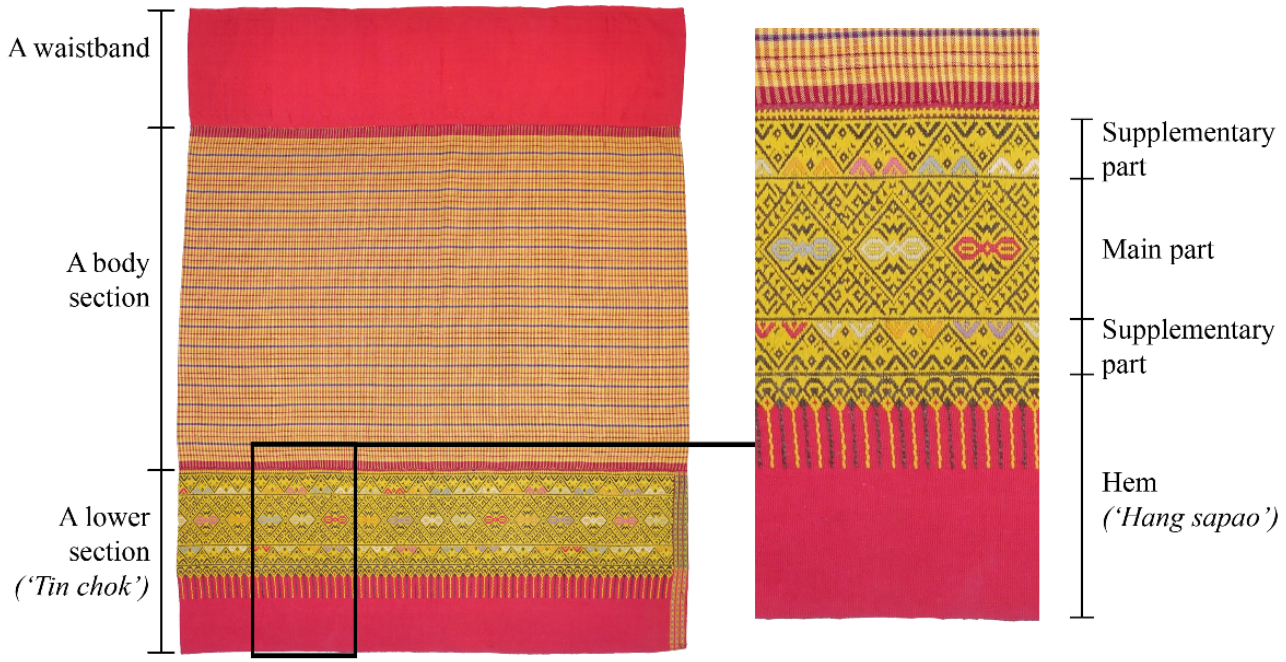
Figure 1. “Sin tin chok” from Komol Phaboraan Museum, Long district, Phrae province. (Photo by Chudasri).